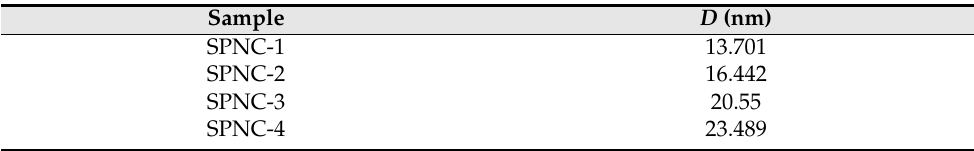
Table 2. Crystallite size calculation for CeO 2 at various